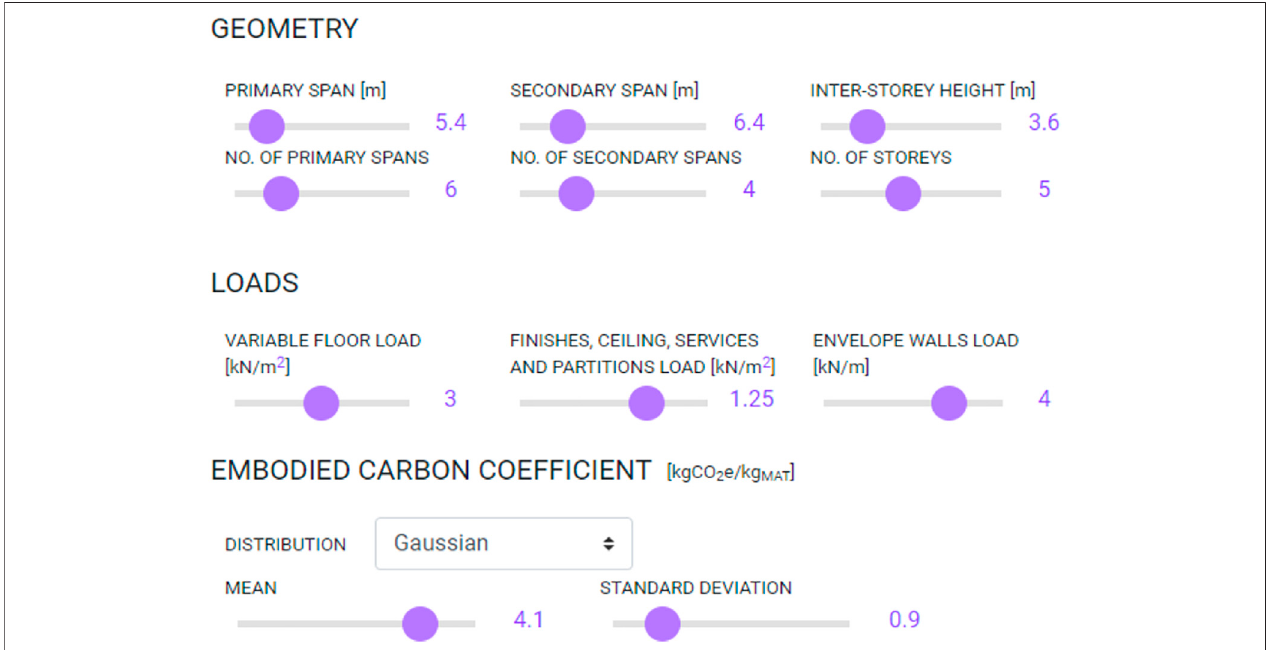
FIGURE 3 | Graphical user interface of the plugin implemented for SketchUp. Input parameters are organised in three main categories: geometric, loading and embodiedcarboncoef fi cients.Theinputslidersallowtheusertoselectaspeci fi cvalueinarangethathasbeenpreviouslyde fi nedbysubjectmatterexperts(FPandBD), which was used to train the ML